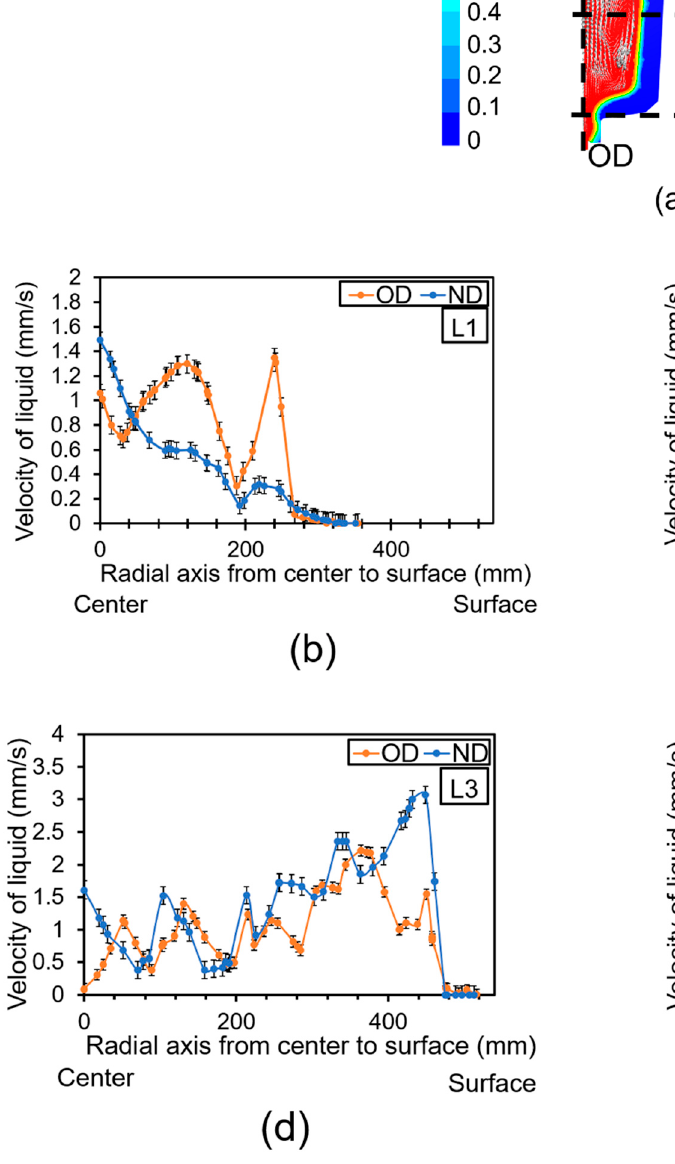
Figure 10. ( a ) Liquid fraction and fluid velocity vectors of OD and ND at a 33% solid fraction, ( b ) Evolution of velocity magnitude of liquid in OD and ND in L1, ( c ) L2 ( d ) L3, ( e )